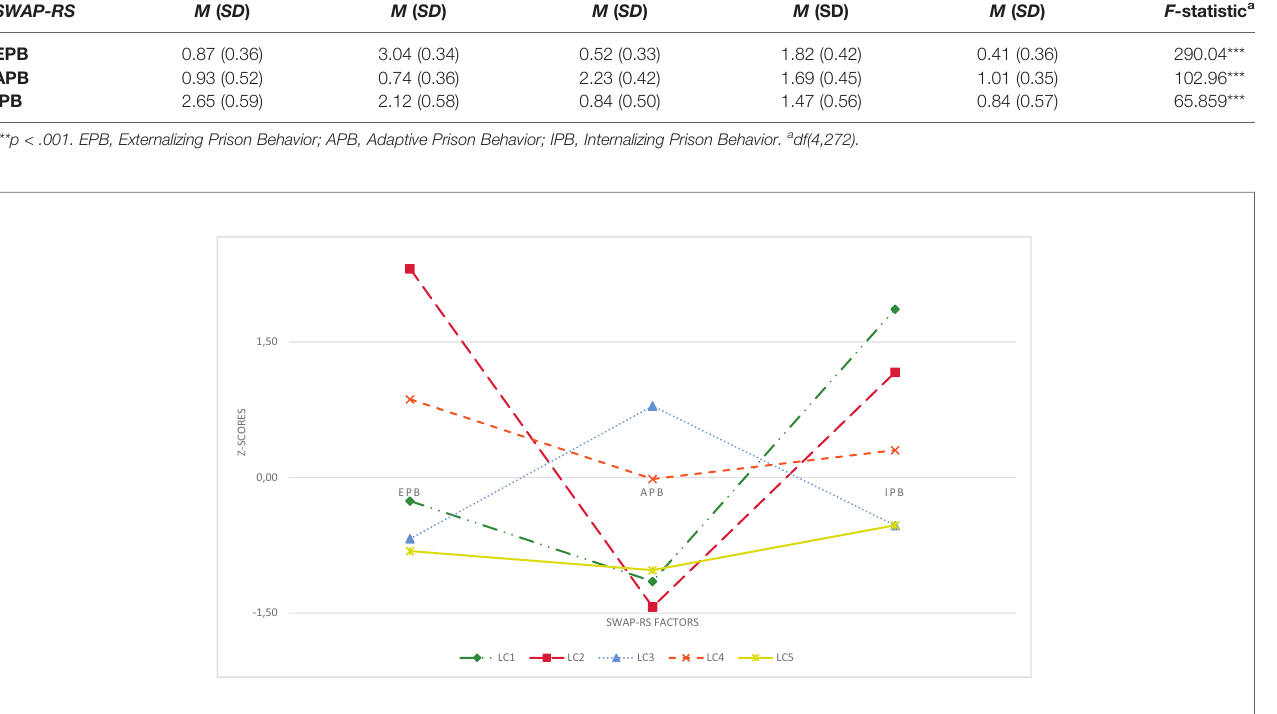
FIGURE 1 | Standardized mean scores of the fi ve latent classes on each Shedler-Westen Assessment Procedure – Rating Scale (SWAP-RS)